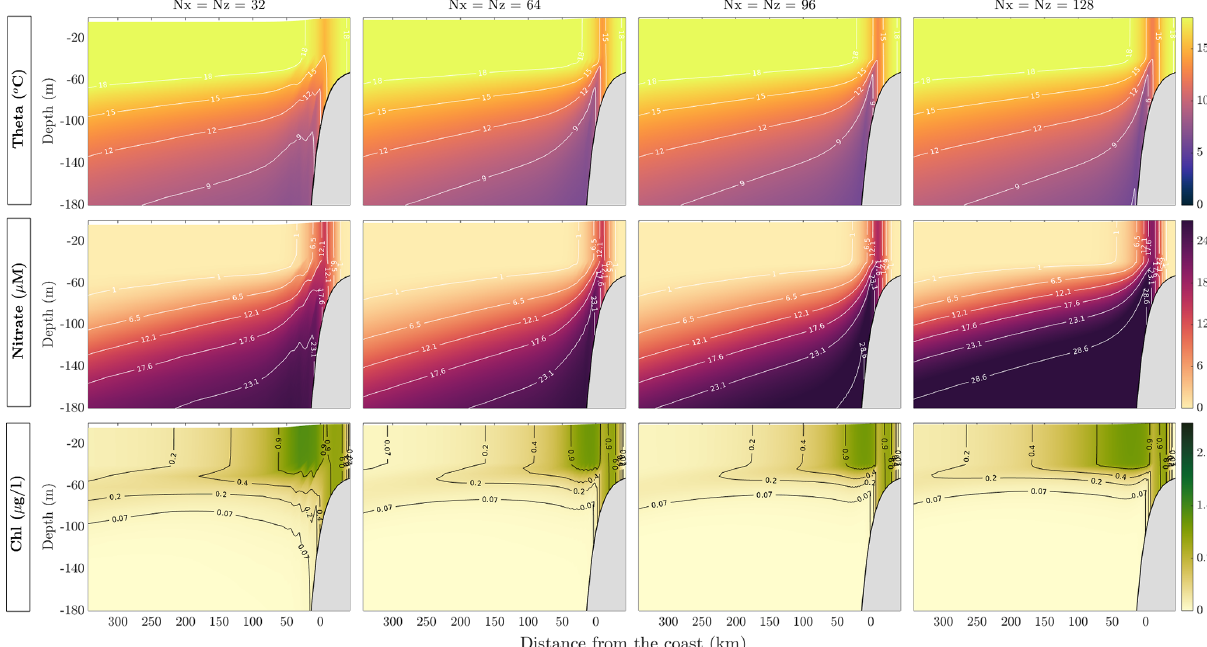
Figure 9. This figure shows the model output of temperature, nitrate, and chl with varying resolution. The model was run for 30 years, and solutions shown are averaged over the final 30 years of the model